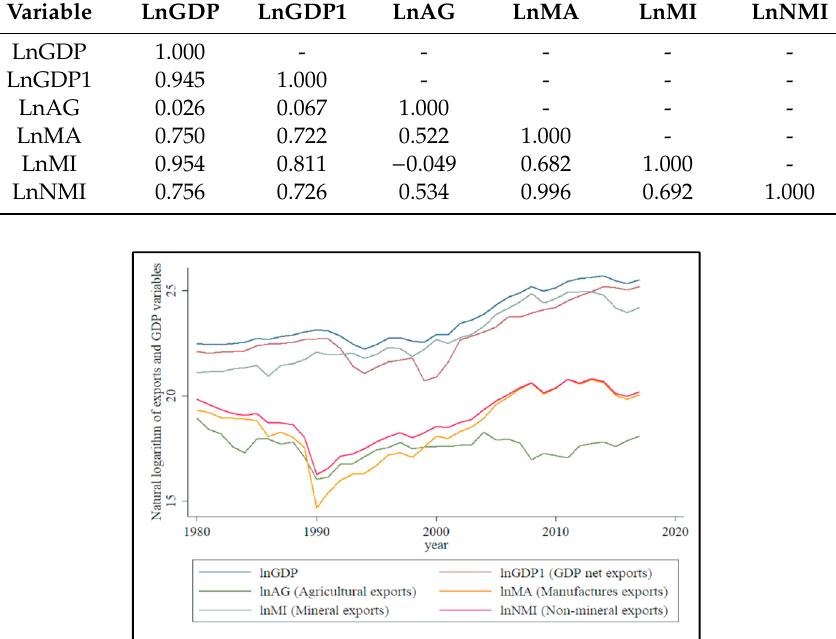
Figure 1. Trend diagram of the variables.